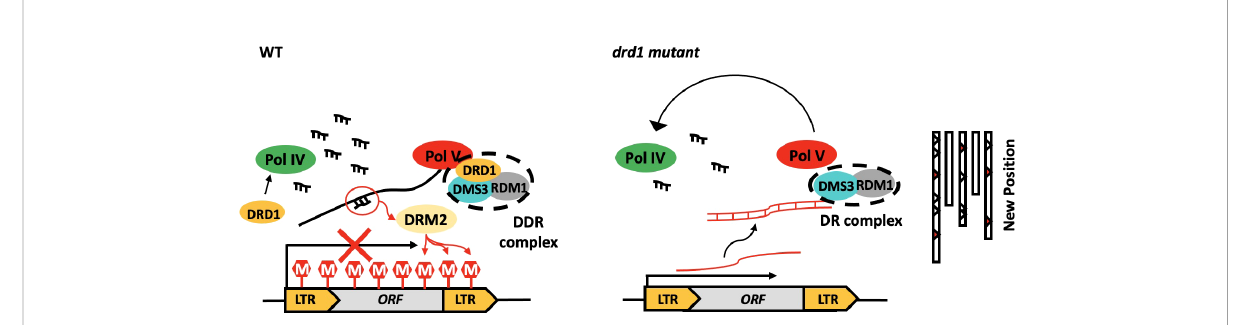
FIGURE 6 Hypothetical model of silencing of ONSEN by DDR complexes. In the wild type, Pol IV and PolV produce siRNA and lncRNA, respectively, resulting in high methylation levels of the ONSEN . High DNA methylation levels result in the silencing of ONSEN transcription. In addition, no ONSEN transposition occurred in WT. In drd1 , the deletion of DRD1 prevents the DR complex from binding to Pol V. It may also affect the localization of NRPD1b. This leads to a partial loss of function of Pol IV and Pol V, which indirectly affects the amount of siRNA and lncRNA accumulation in vivo , leading to the deregulation of ONSEN transcription and transposition silencing